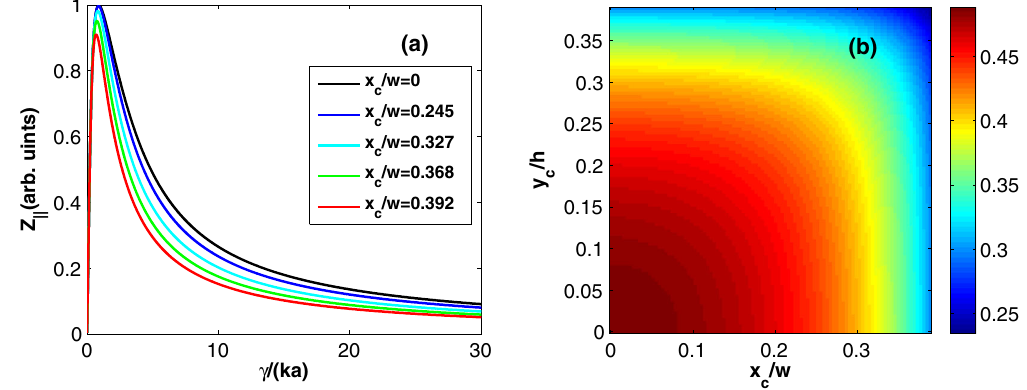
FIG. 11. The effect of beam offset ( x , y ) in a square chamber on the on-axis impedance. The impedance in the entire wavelength c c ¼ 0 ) is shown in plot (a); and the impedance at one particular wavelength γ = ð ka Þ ¼ 5 spectrum with different horizontal offsets x ( y c c for various ( x , y ) is shown in (b). The round uniform beam has a radius of a ; the full width and height of the chamber are w ¼ h ¼ 10 a c c